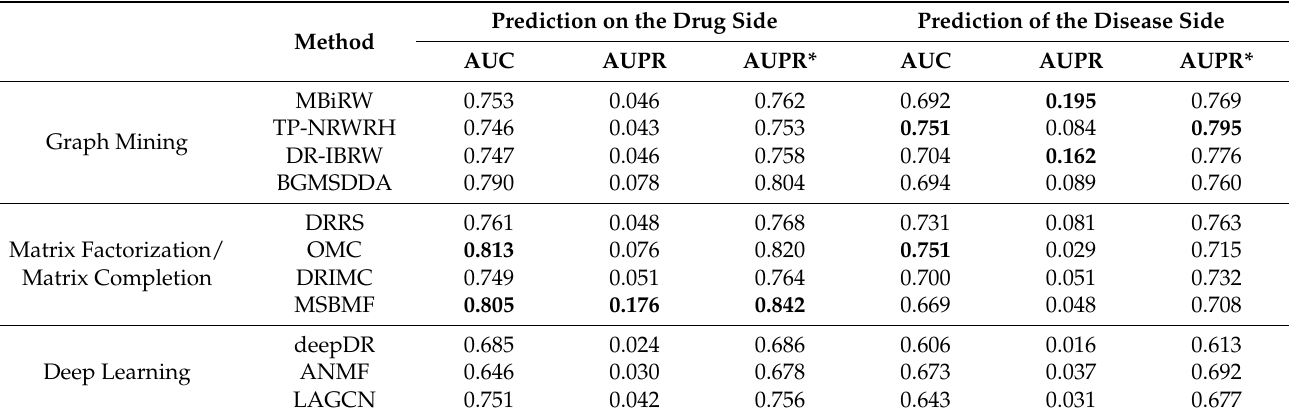
Table 3. AUC, AUPR, and AUPR* of drug–disease association prediction results using network-CS. Values close to the highest are expressed in bold.